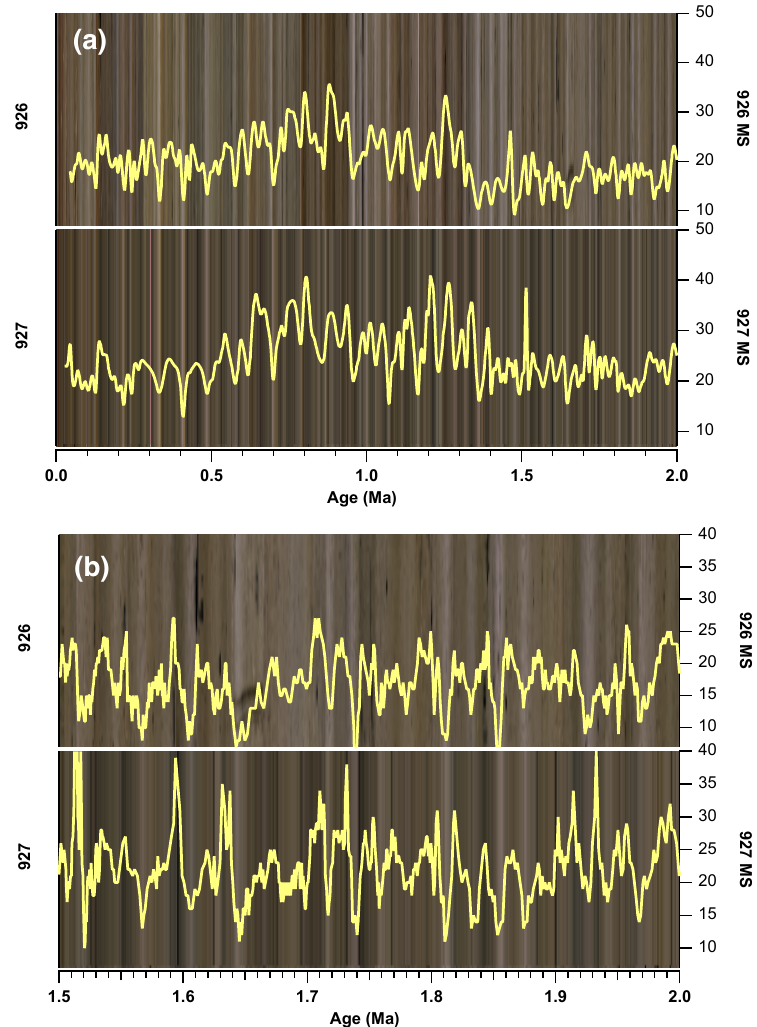
Figure 6. (a) Smoothed MS data and images plotted versus age from 0–2Ma. (b) 1.5–2Ma detail using non-smoothed data. Fine layers, on the order of 10kyr, are correlated between sites 927 and